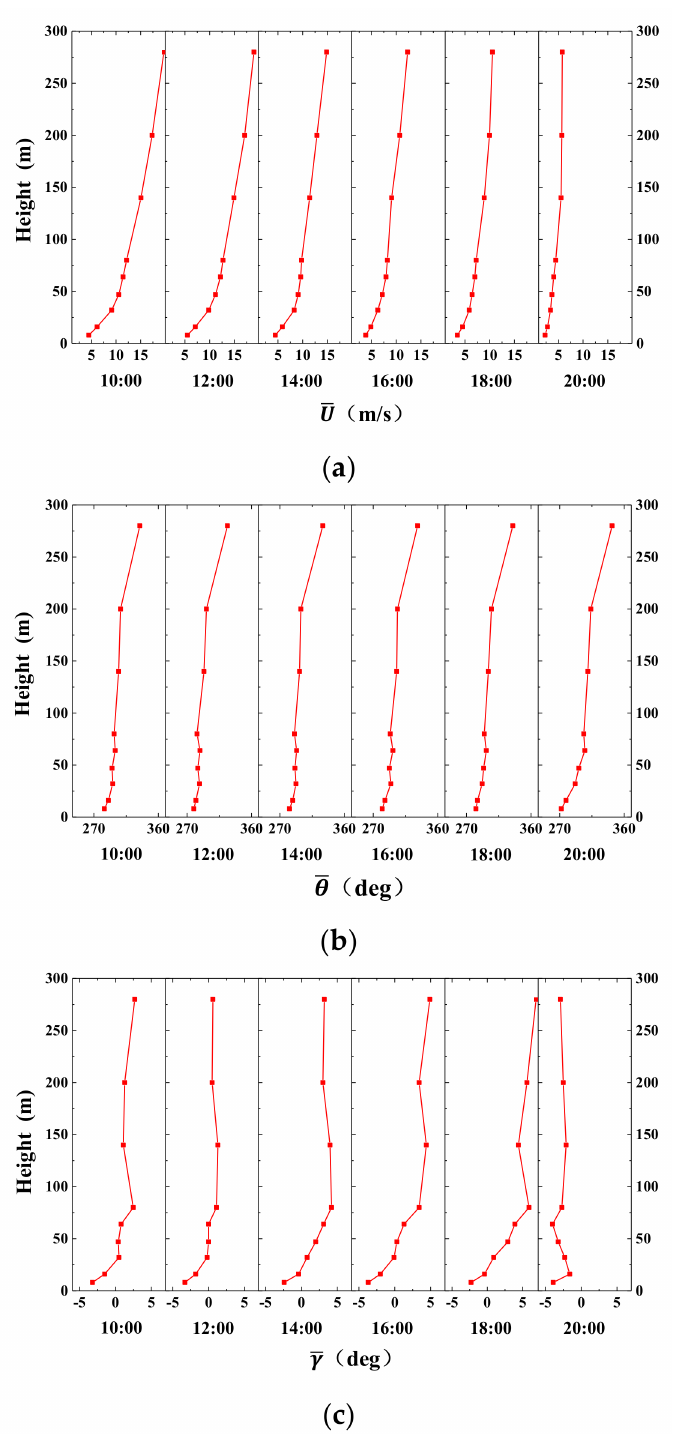
Figure 13. The profile variation of the 10-min mean wind speed ( a ), hotizontal direction ( b ) and wind angle of attack ( c ) of the synoptic event which occured on 5 May